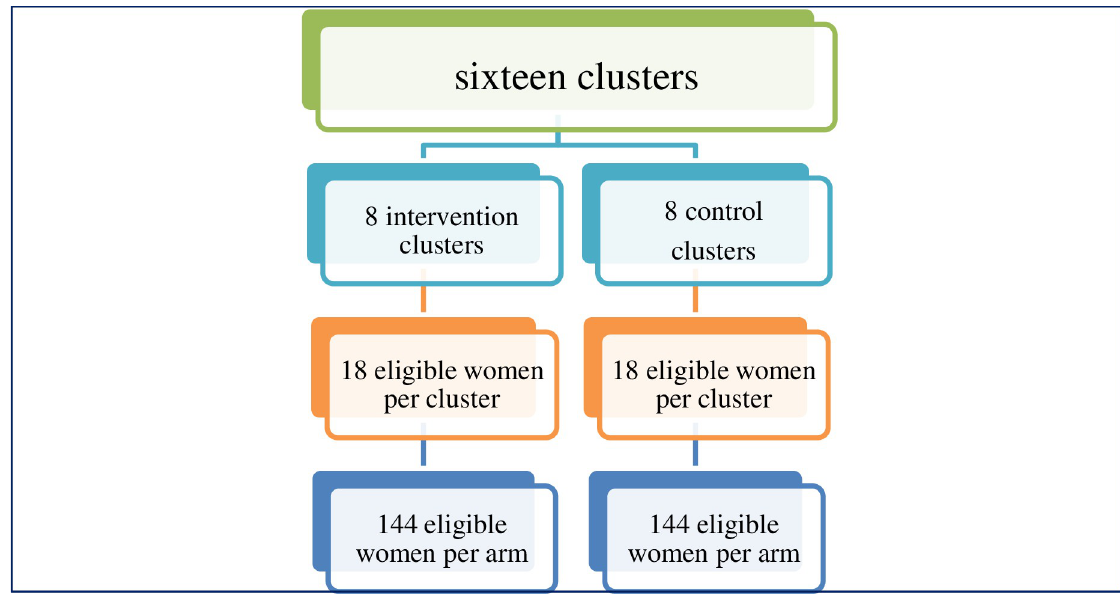
Fig 2. Sampling procedures of the study